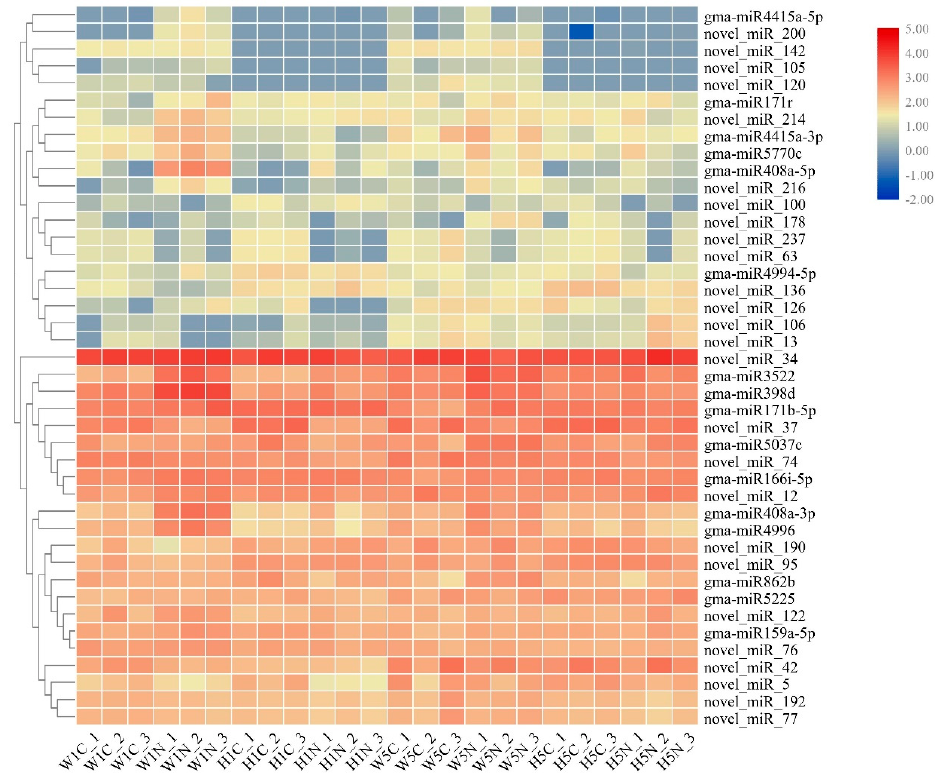
Figure 4. Hierarchical clustering analysis of all the di ff erentially expressed miRNAs. The di ff erentially expressed miRNAs were analyzed by hierarchical clustering base on log10 (TPM + 10 − 6 ) values of miRNAs, and the miRNAs with the same or similar expression pattern were clustered. The columns represent di ff erent samples and rows represent di ff erent miRNAs, clustered with values, with red representing high miRNA expression and blue representing low miRNA expression. To validate the sequencing data and our DE analysis of miRNAs, we conducted qRT-PCR using the same 24 RNA samples. In each DE set, three differentially expressed miRNAs found in silico were randomly selected for qRT-PCR experiments. The results of the qRT-PCR showed that the expressions of most of the miRNAs (19 of 24 selected miRNAs) agreed with the sequencing result.